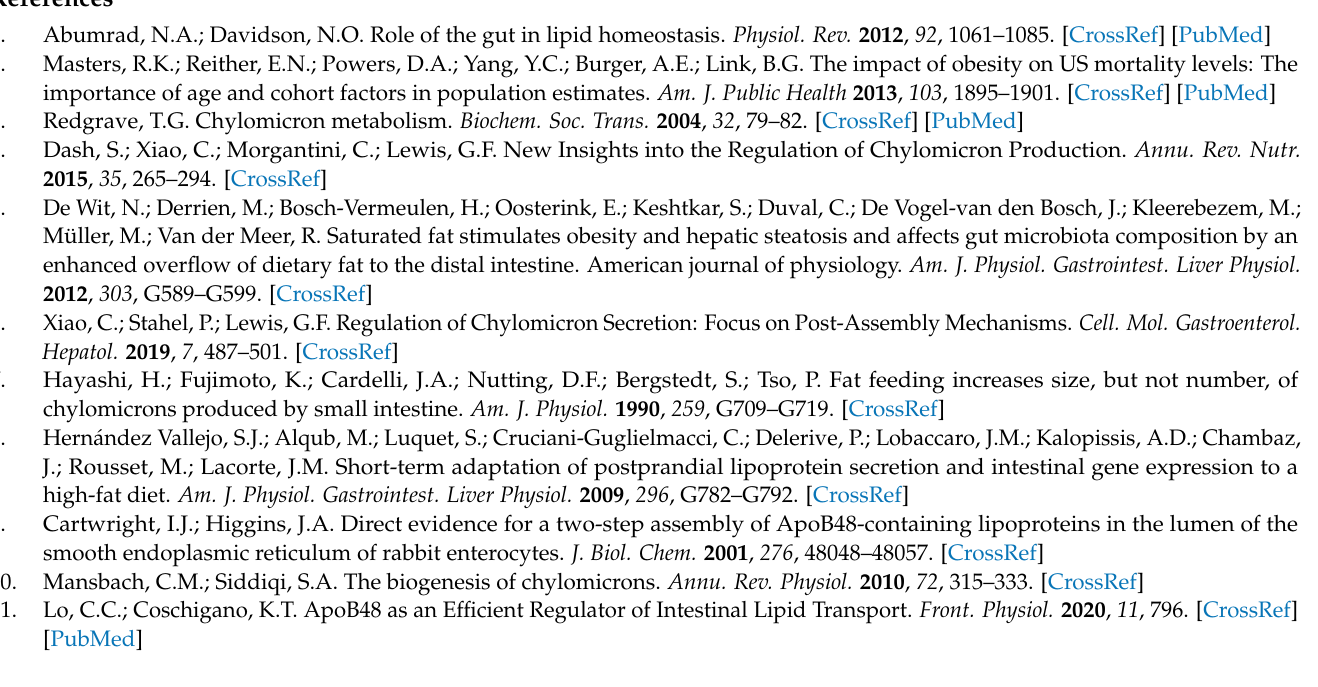
Figure S2: The fraction of density gradient separation for lipoprotein; Figure S3: The knockdown efficiency of perk gene in IECs; Figure S4: mRNA levels and Western blot analysis of perk in the IECs under FA and CH incubation and transfected with si-perk ; Figure S5: Prediction analysis of CpG islands in the sequence range of 2300 bp upstream from the transcriptional start site in the perk promoter region (http://www.urogene.org/). TSS, transcription start site; Figure S6: Bisulfite sequencing of the promoters of perk between the control, HFD, CH and HFD + CH. S7; Figure S7: Heat map of methylation percentage of perk in the IECs under FA and CH incubation and addition AZA; Figure S8: The -198 and -195 methylation sites relative luciferase activities of perk in the IECs under FA and CH incubation.Table S1: Feed formulation and proximate analysis of experimental diets; Table S2: Effects of dietary high fat and choline supplementation on growth performance and morphological parameters yellow catfish ( Pelteobagrus fulvidraco ) after 10 weeks; Table S3. Primers used for plasmid construction and RT-qPCR